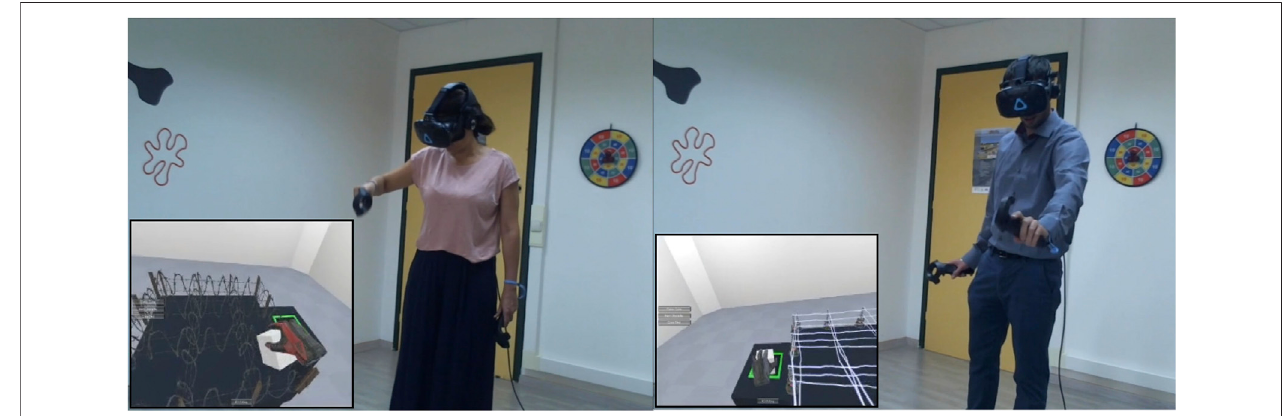
FIGURE 2 | The versions of the virtual hand representation that were used during the study: (A) Slim version, (B) Thick version.